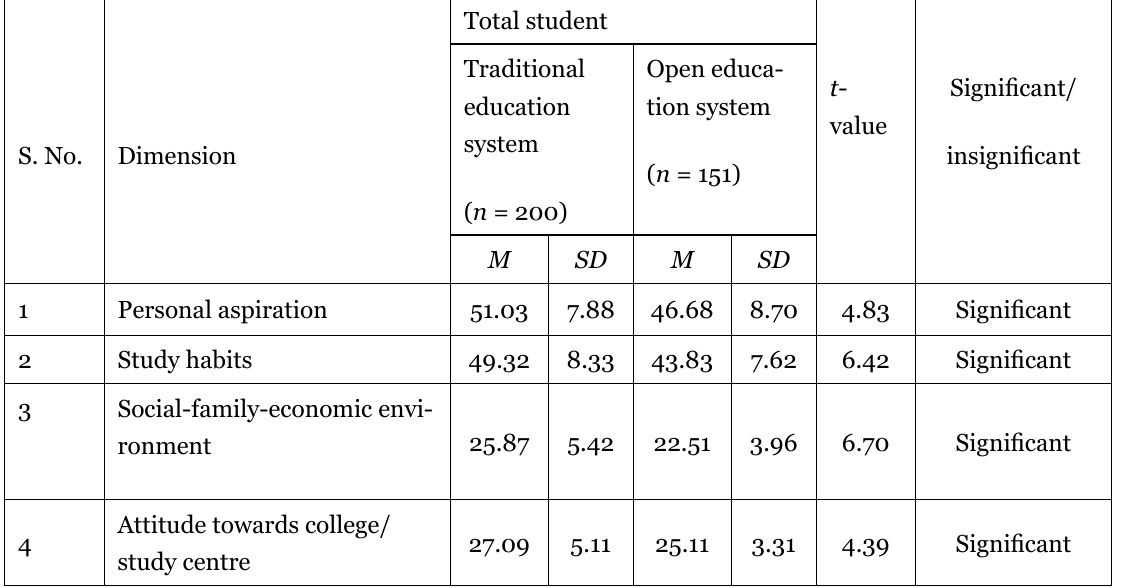
Comparison of Academic Motivation of Students Studying in TES and OES Dimension- wise